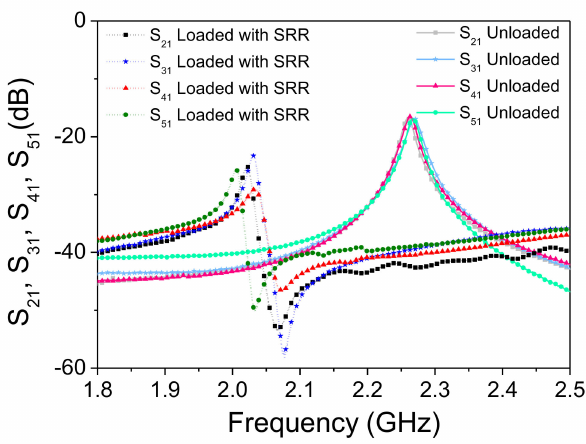
Figure 6. Transmission coefficient for the different channel lines with and without SRR tags on top of them.